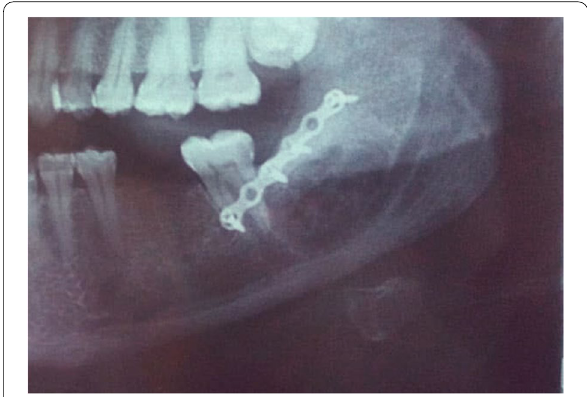
Fig. 7 Postoperative radiographs after 2 months showing complete bone healing and integrity of the osteotomized buccal cortex